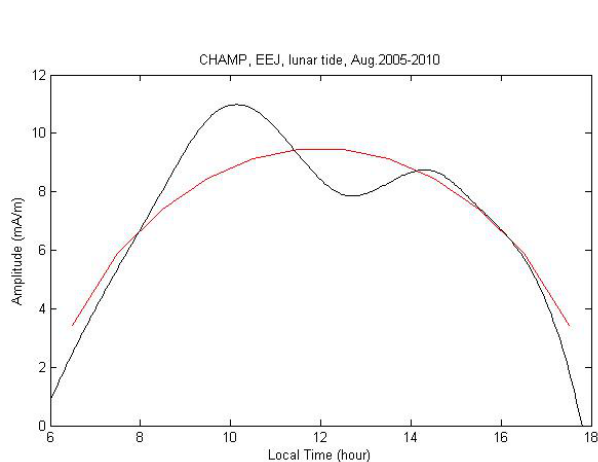
Fig. 9. Diurnal variation of lunar tidal amplitude (black curve) compared with the square root of the cosine of the solar zenith angle (red curve). The latter function reflects the electron density variation of a Chapman layer.